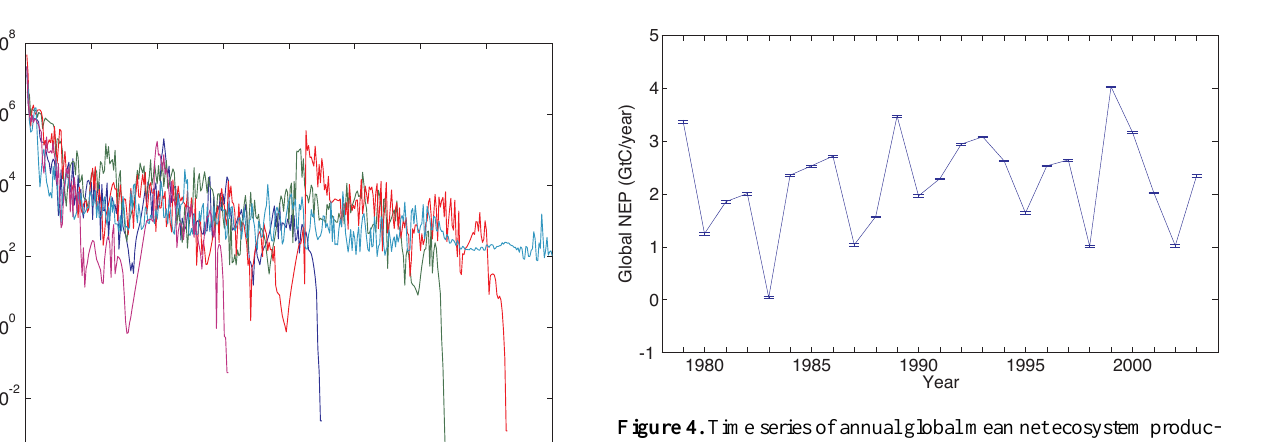
Figure 4. Time series of annual global mean net ecosystem produc- tivity (NEP) with posterior